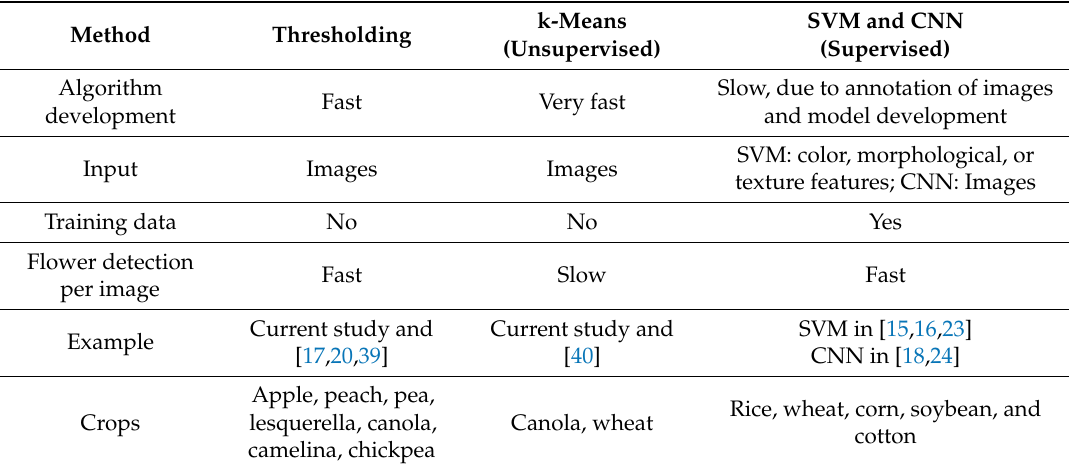
Table 5. Comparison of methods of flower